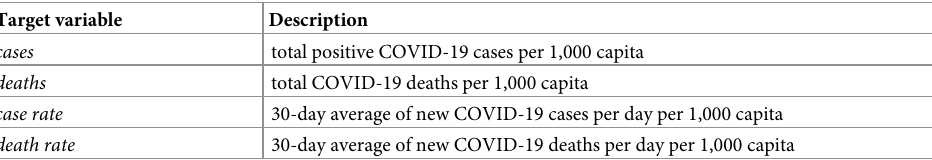
Table 1. COVID-19 outcomes per county.